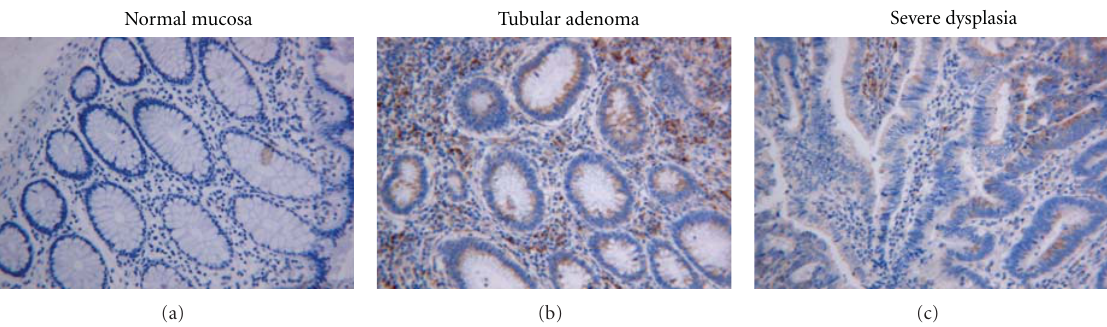
Figure 2: The expression of Cx43 in normal colonic mucosa, tubular adenoma, and severe dysplasia (Original magnification × 200). There is an increase in cytoplasmic Cx43 expression from normal epithelium (Cx43 score 4 ± 1) to tubular adenoma/severe dysplasia (Cx43 score 20 ±